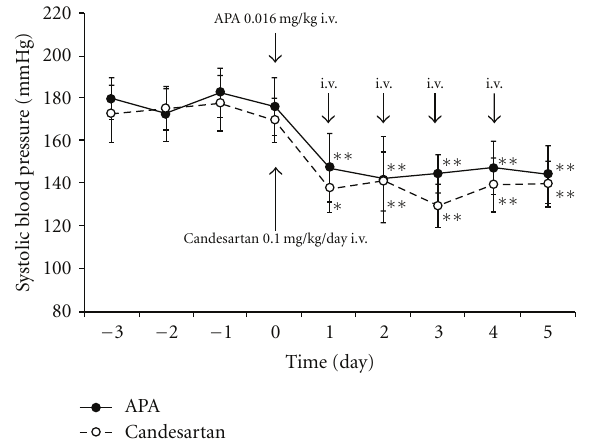
Figure 4: Comparison of APA (0.016mg/kg) and candesartan on BP in SHRs. Intravenous injection of recombinant APA ( n = 5) and candesartan ( n = 5) significantly decreased SBP for 5d in SHRs. The magnitude of the antihypertensive e ff ects of APA (0.016mg/kg) and ARB (0.1mg/kg) was similar. APA (0.016 mg/kg): bolus injection every day for 5 d; candesartan (0.1 mg/kg): continuous infusion by osmotic minipumps for 5d. ∗ P < . 05, ∗∗ P < . 01 compared with pretreatment